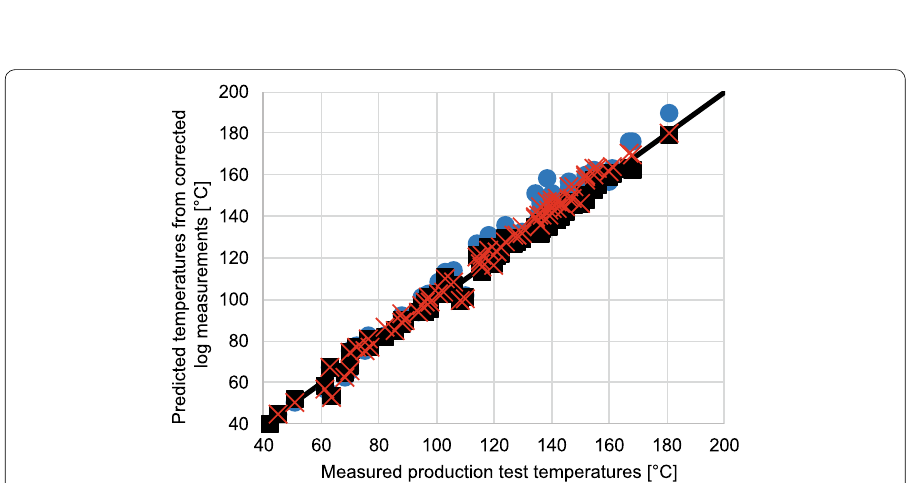
Fig. 7 Predicted temperatures from corrected log measurements versus temperatures measured during production tests. The black line indicates perfect correlation. Blue dots: method A; black squares: method B; red crosses: method